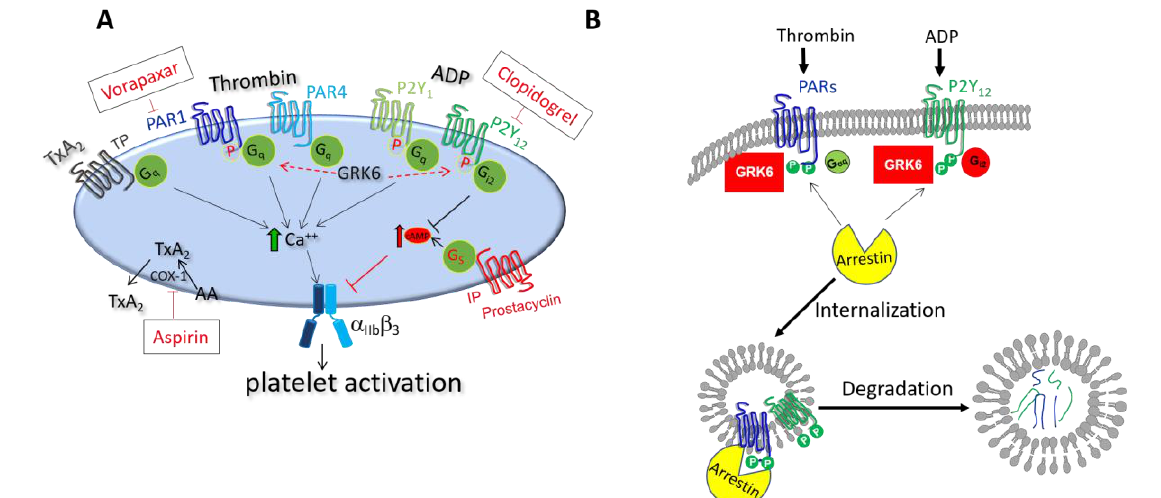
Figure 1. Feedback regulation of G protein coupled receptor (GPCR) signaling by GRK6 in platelets. ( A ) GPCR signaling in platelets. Many antiplatelet drugs target GPCRs signaling pathways, including PAR1 antagonist (vorapaxar), thromboxane A 2 synthesis (aspirin), and ADP signaling (clopidogrel). Left : GPCR kinases (GRKs) are a critical negative regulator of GPCRs. ( B ) A model of GPCR desensitization and internalization in platelets. GRK6 regulates PARs and P2Y 12 -mediated signaling during platelet activation. In response to thrombin or ADP stimulation, GRK6 binds to PARs or P2Y 12 in platelets and phosphorylates the serine residues of the receptor, leading to the desensitization of PARs or P2Y 12 . Arrestins are also involved in this